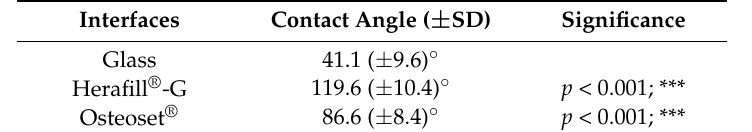
Table 1. Blood contact angle measurement ( n = 8) mean results in degrees ( ± standard deviations) and p -values of student’s t -test referred to glass (Levels of significance used were ***: p < 0.001).